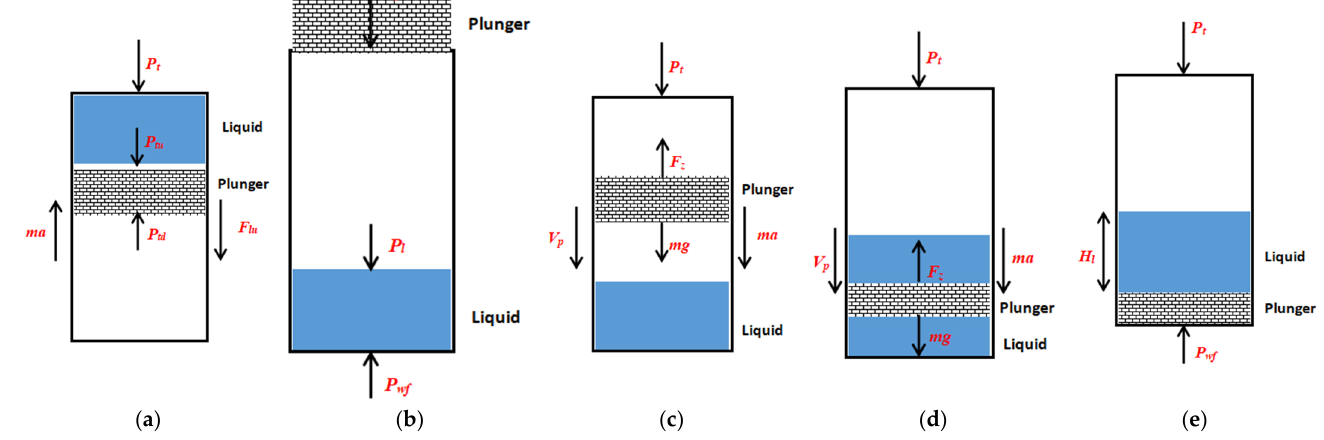
Figure 1. ( a ) Uplink phase; ( b ) Continuous phase; ( c ) Downside Phase in the gas column; ( d ) Down- side Phase in liquid; ( e ) Pressure build-up phase.